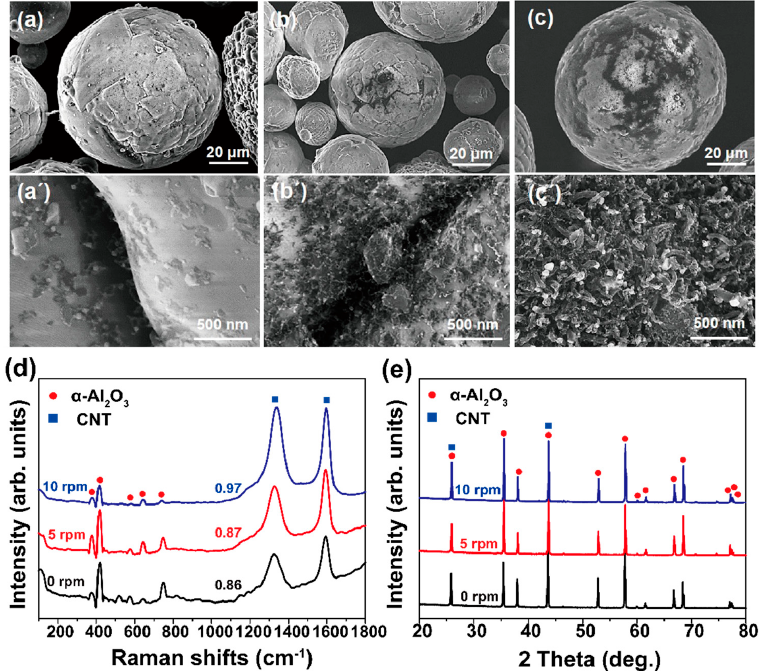
Figure 6. Low ‐ and high ‐ magnification SEM images showing CNTs directly grown on Al 2 O 3 parti ‐ cles at 650 °C for 10 min. The rotation condition is ( a ) and ( a’ ) 0, ( b ) and ( b’ ) 5, ( c ) and ( c’ ) 10 rpm. ( d ) Raman spectra and ( e ) XRD profiles obtained from ( a ) to ( c )